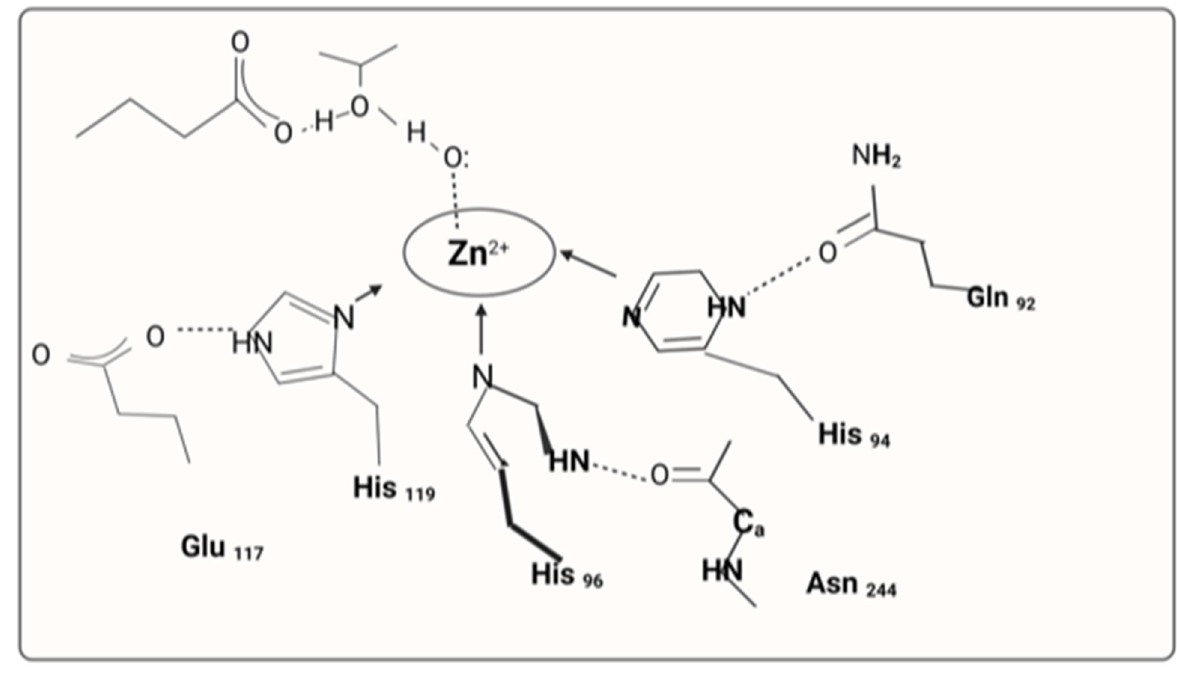
Figure 3. Structure elucidation of carbonic anhydrase II activators.